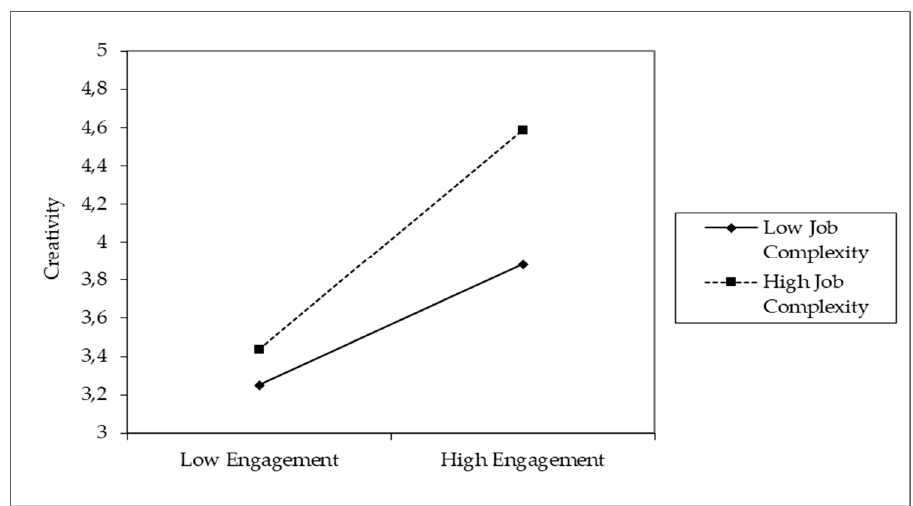
Figure 2. Moderating effect of job complexity on the engagement–creativity relationship.